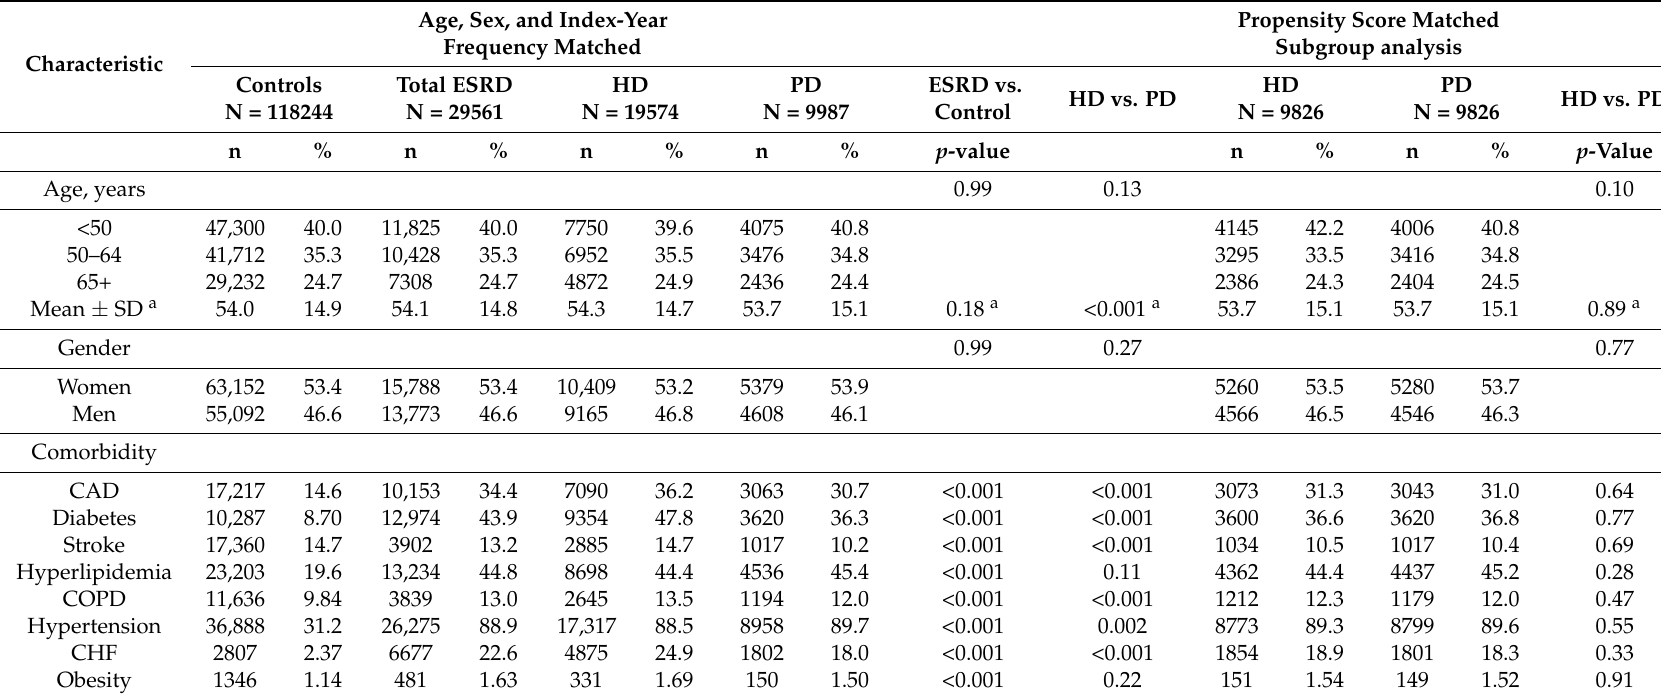
Table 1. Distributions of demographic parameters and comorbidities in ESRD and control